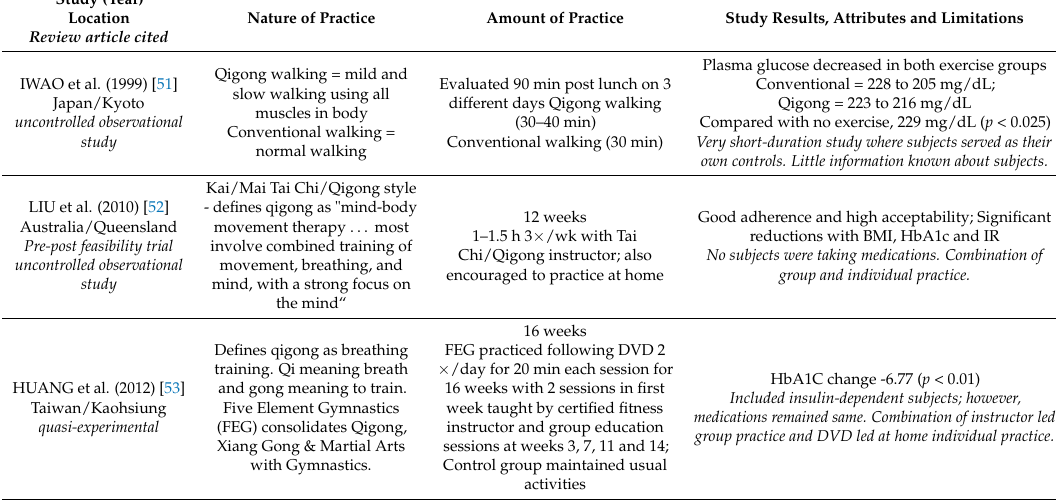
Table 3. Summary of other studies evaluating the effects of qigong in adults with type 2